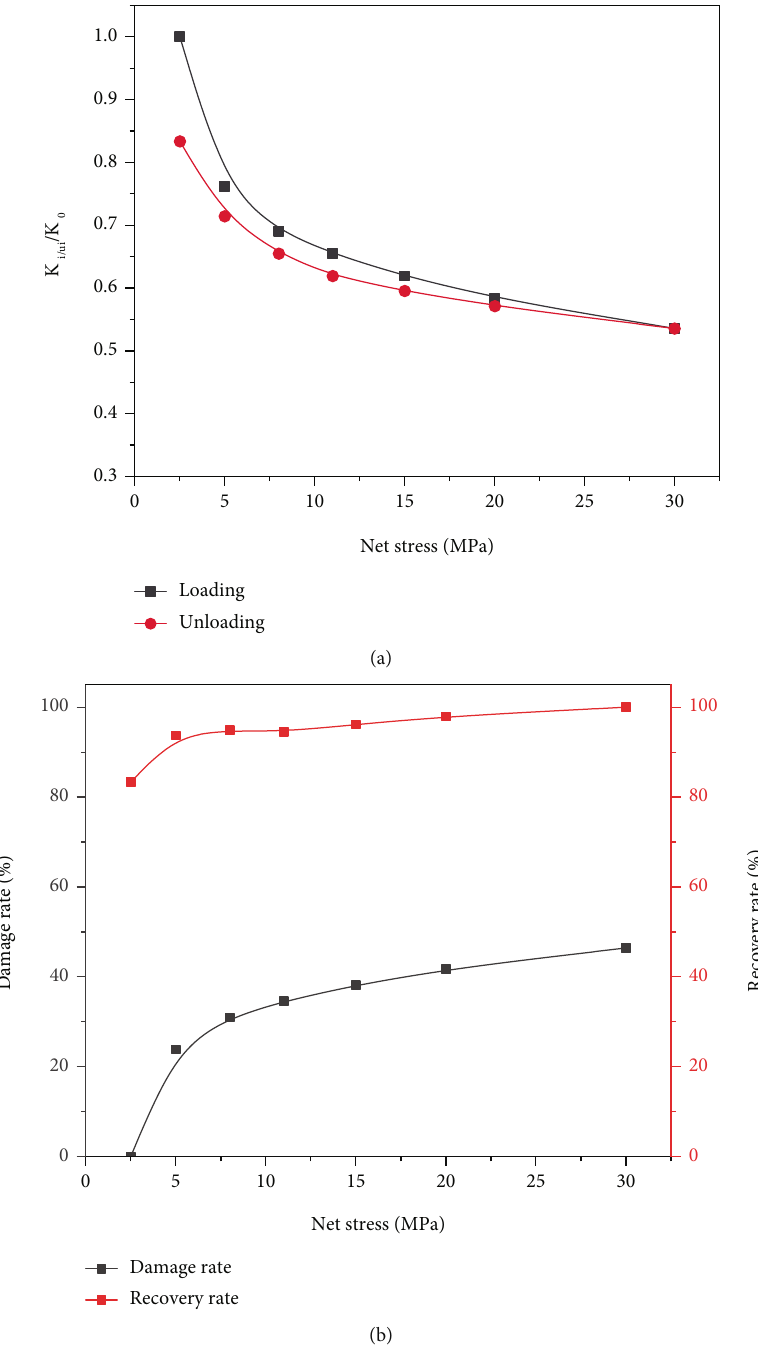
Figure 3: Variable fl ow pressure: (a) the relation between dimensionless permeability and net stress; (b) permeability damage and recovery rate under di ff erent net